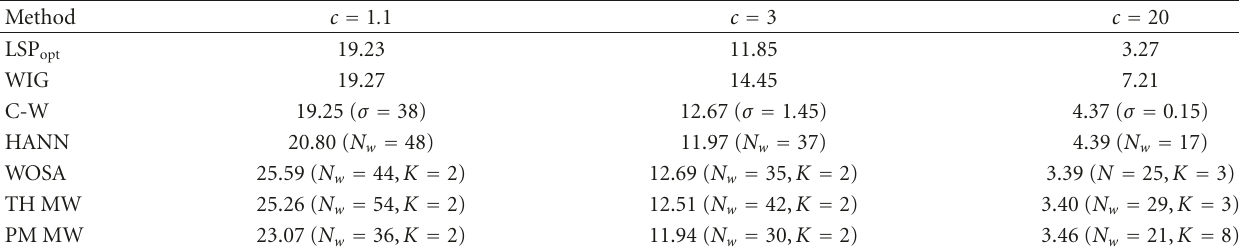
Table 1: The mean square error of the LSP-optimal multitapers and weights (LSP opt ) compared to optimal choices of parameters of di ff erent methods evaluating the class of LSPs when c = 1 . 1, 3, and